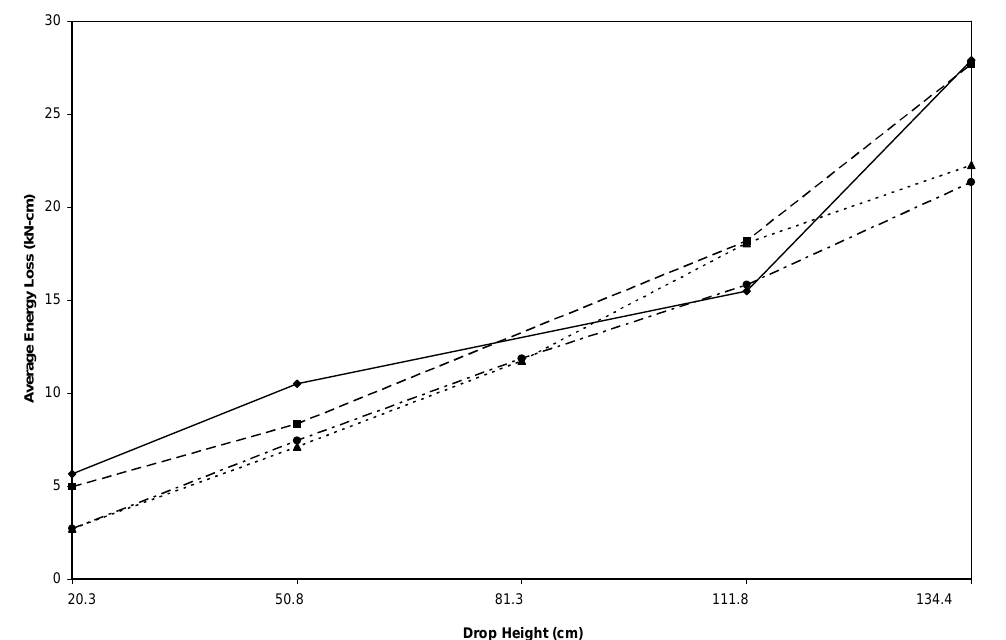
Fig. 10. Effect of height on average dissipated energy during sequence of 20 dynamic tests; solid = precycled Amsteel Blue, 1.27-cm diameter; dashed = new Amsteel Blue, 1.27-cm diameter; dotted = precycled Amsteel II, 0.95-cm diameter; dash-dot = new Amsteel II, 0.95-cm diameter.